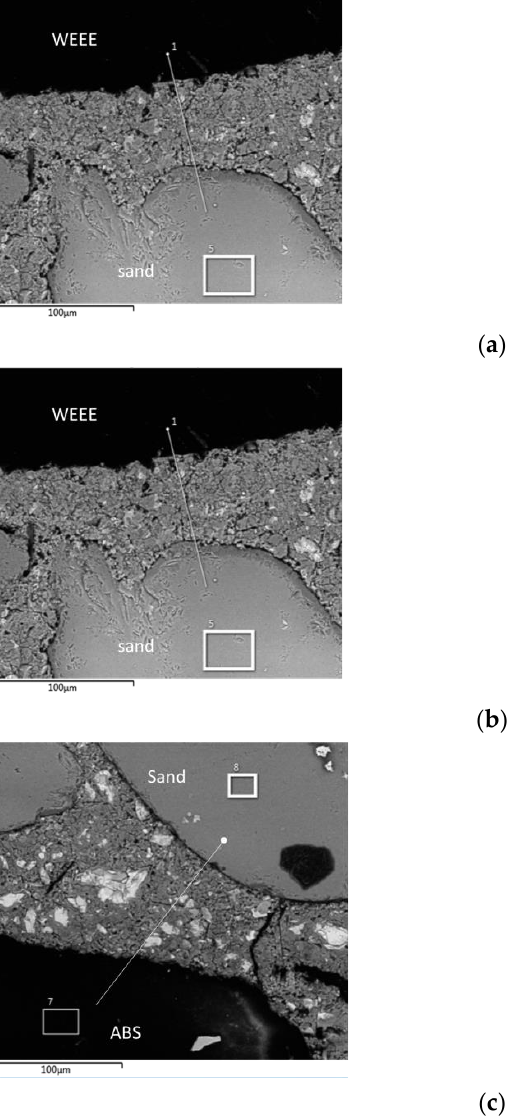
Figure A3. SEM/EDX observations. ( a ) EDX profile of WEEE. ( b ) EDX profile of sand. ( c ) EDX profile of ABS.